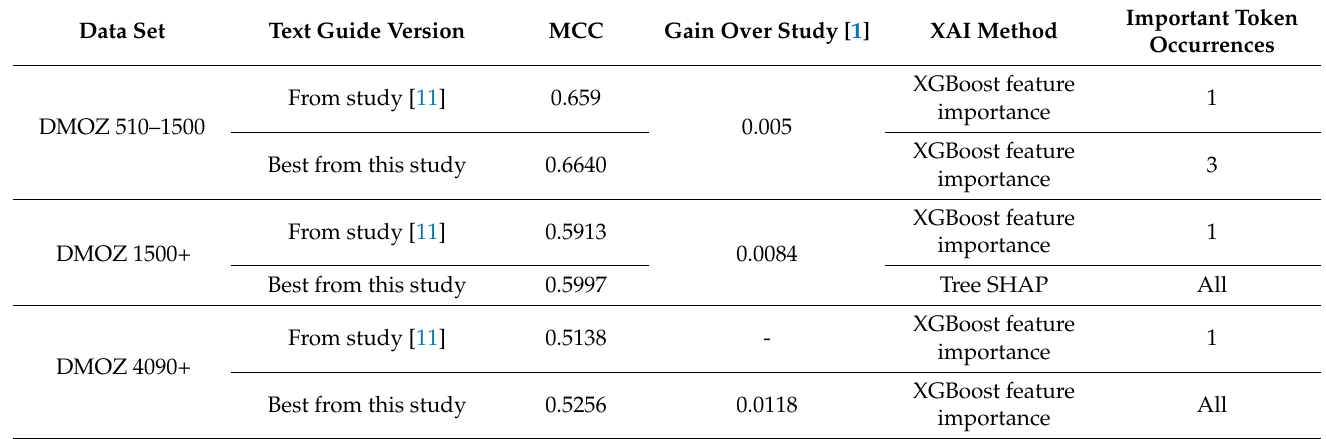
Table 8. Comparison of results achieved by the original Text Guide method [11] and best results from our study. The pre- sented results were obtained by pre-trained AlBERT models. Only the varying parameters of the Text Guide were mentioned. Data